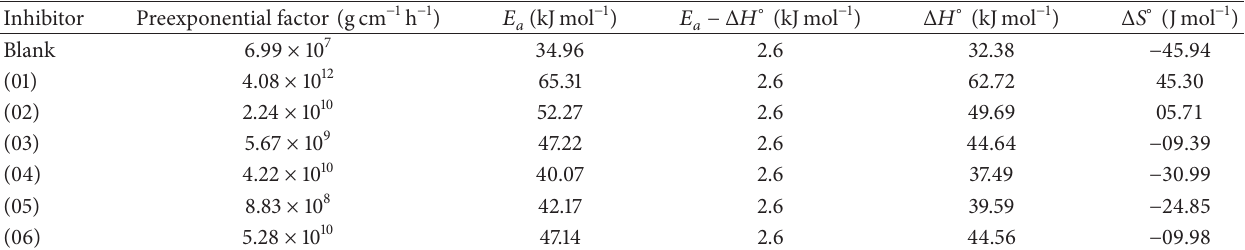
SO in the absence and presence of variously 2 4